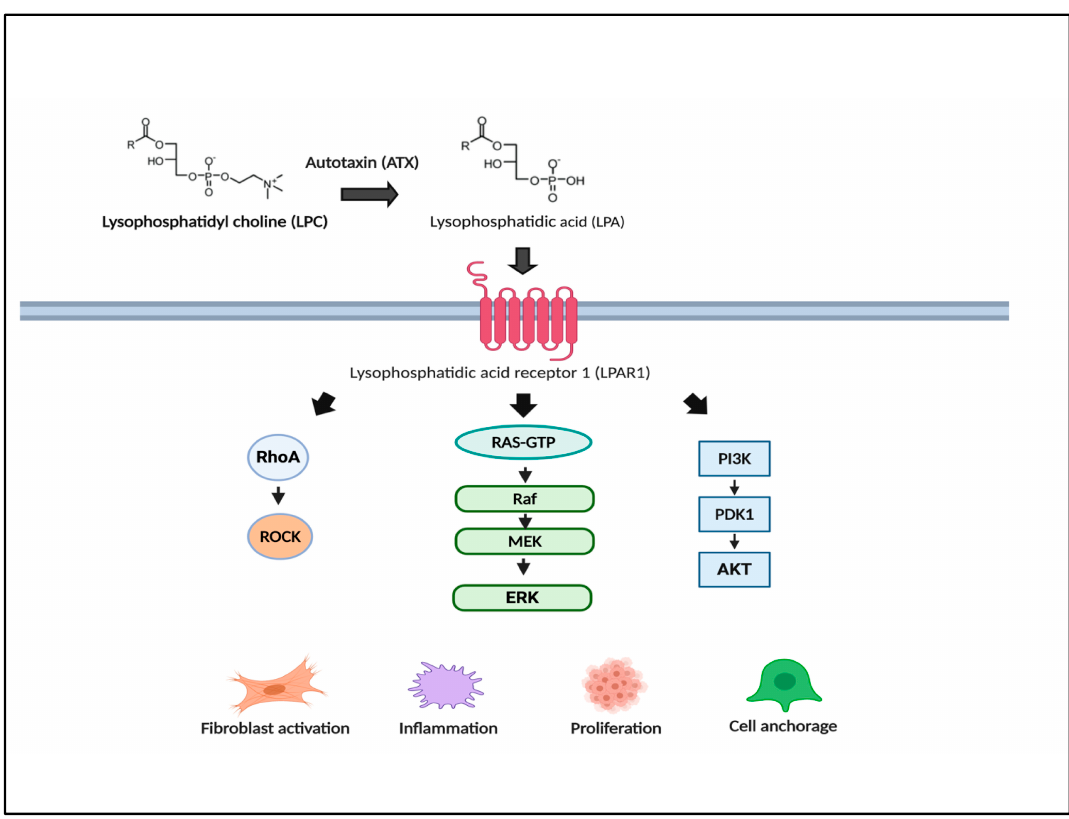
Figure 3. Lysophosphatidic acid (LPA) pathway as a novel chemoprevention target. Reverse engineering transcriptome analysis revealed the LPA pathway as a target for HCC prevention. LPA and its G protein-coupled receptors, lysophosphatidic acid receptors (LPARs), promote fibrosis, inflammation, and carcinogenesis through the activation of down-stream RhoA, Ras/mitogen-activated protein kinase (MAPK)/extracellular-signal-regulated kinase (ERK), and Akt/PI3K. LPA activation has been observed in human and rodent cirrhotic livers at risk for HCC.